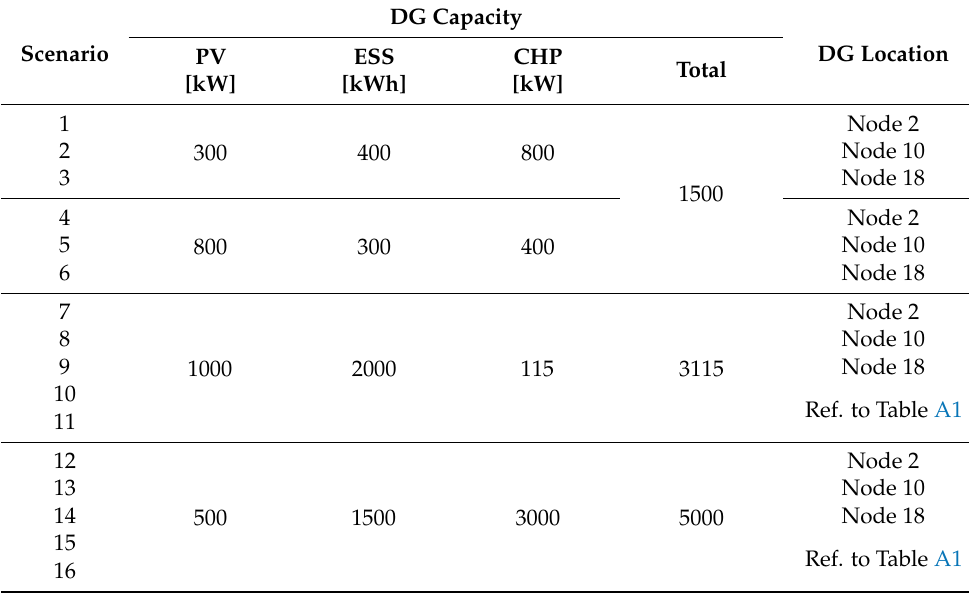
Table 1. Simulation condition of each Scenario for MG planning.